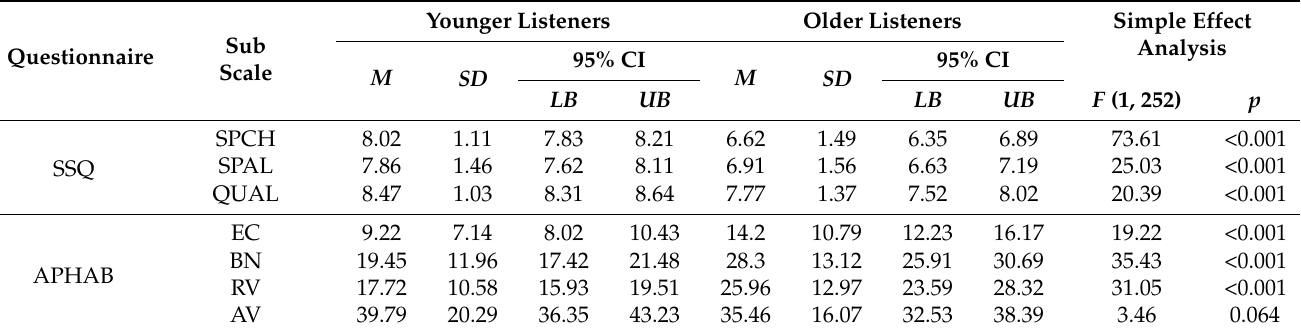
Table 1. Descriptive statistics for the mean ratings of various subscales of the SSQ and APHAB questionnaire and the results of simple effect analyses comparing the mean scores between the younger and older listeners.